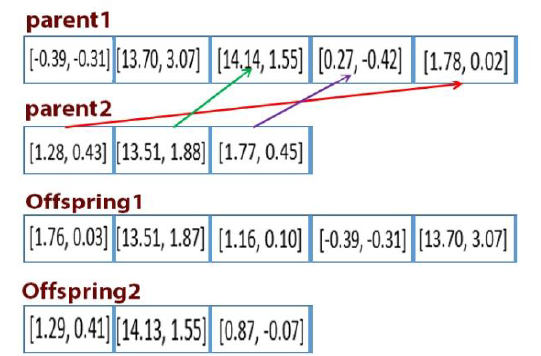
Fig. 1. Crossover of parents with different number of